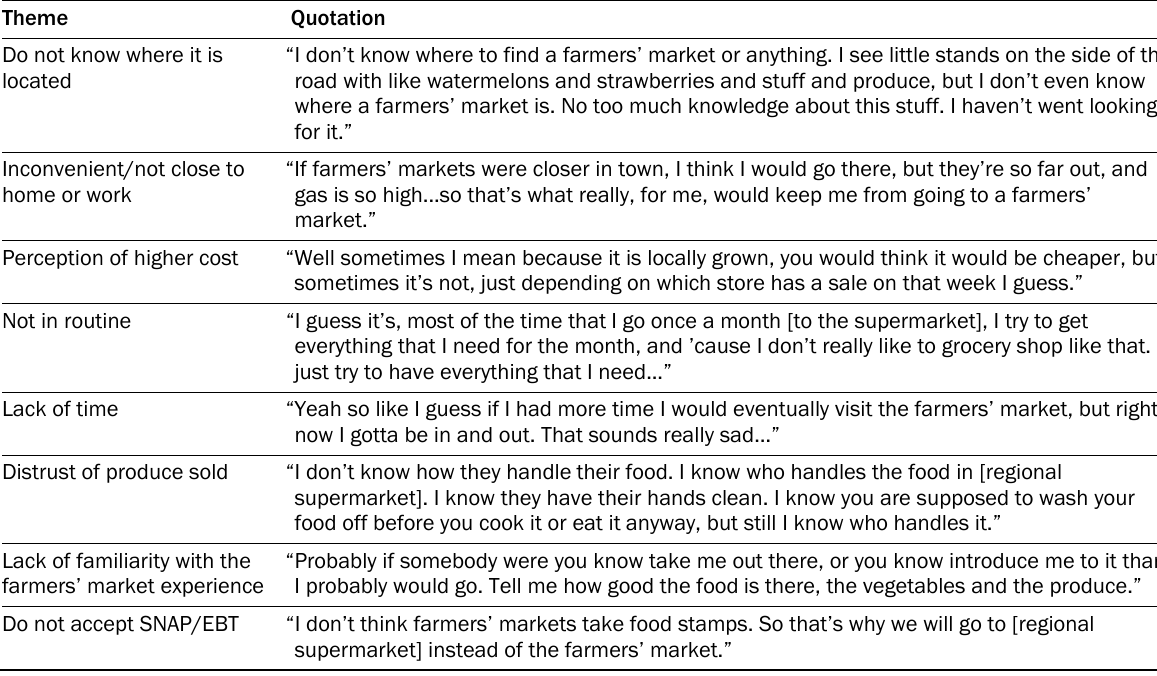
Table 3. ENC Reasons for NOT Procuring Food from Local Food